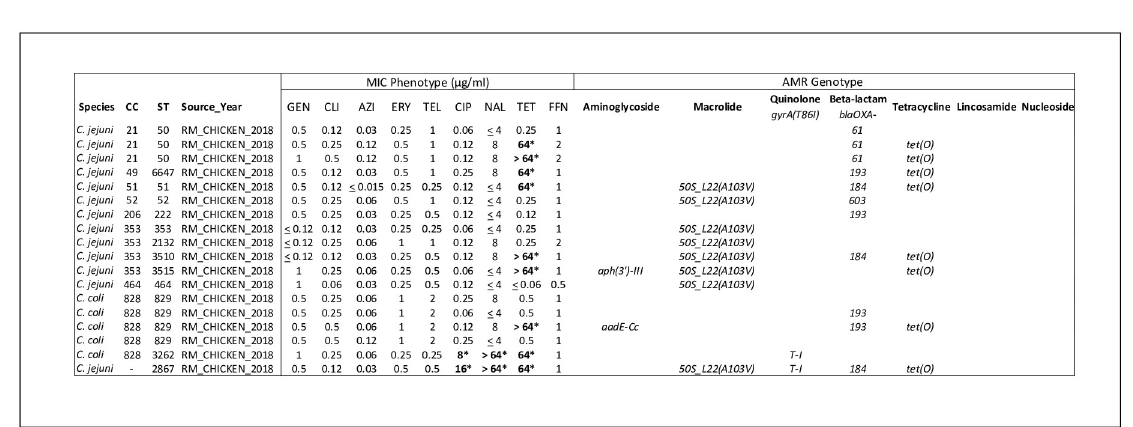
Fig 2. Campylobacter antibiotic susceptibility test results in retail meat aligned with AMR genotype, MLST, and source. Bold ( � ) = resistant. NARMS FDA C . coli and C . jejuni minimum inhibitory concentration (MIC) results for retail meat in North Carolina compared to isolate MLST and AMR genotype. MIC was determined for the following antibiotics: Gentamicin (GEN), Clindamycin (CLI), Azithromycin (AZI), Erythromycin (ERY), Telithromycin (TEL), Ciprofloxacin (CIP), Nalidixic Acid (NAL), Tetracycline (TET), and Florfenicol